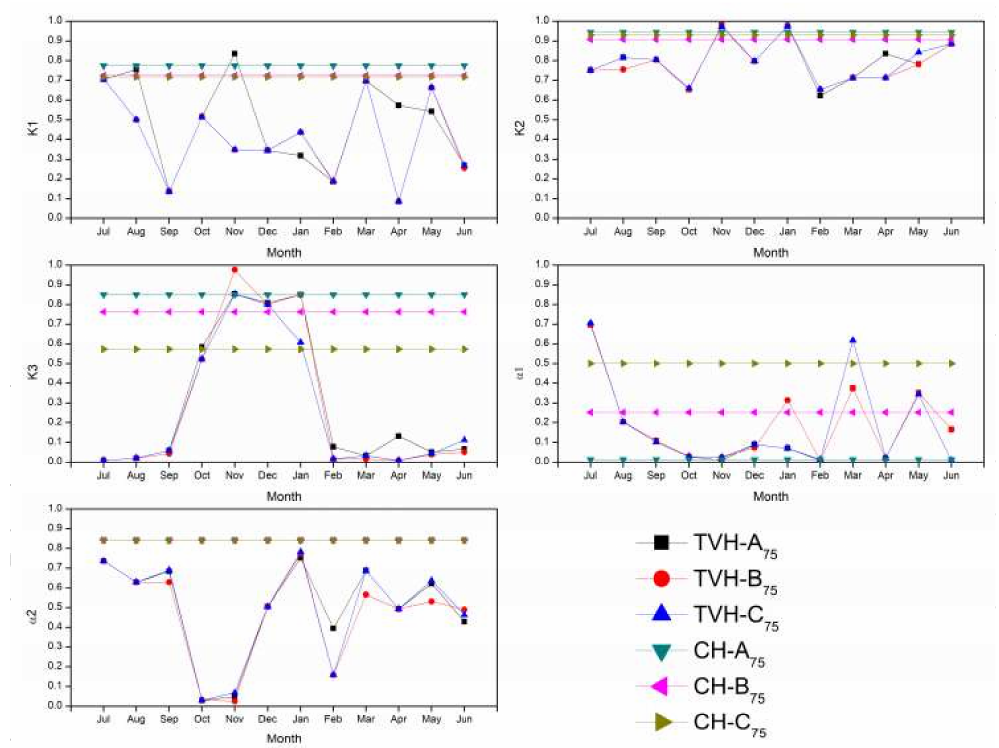
Figure 8. Time-varying hedging (TVH) and constant hedging (CH) parameters (K 1 , K 2 , K 3 , α 1 , α 2 ) for discrete hedging policy—A comparison between the selected pareto-optimal solutions for 75% demand